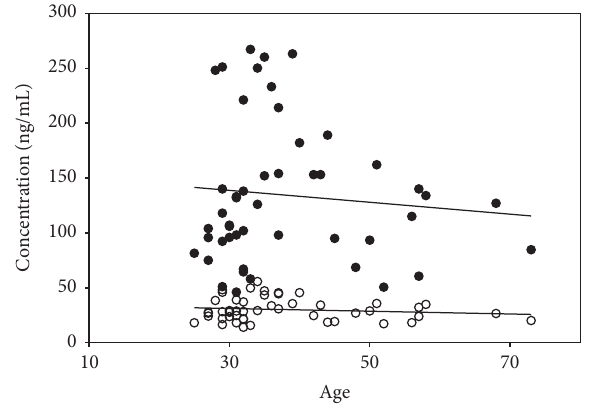
Figure 2: The levels of serum cortisol ( e ) and cortisone ( I ) with age in subjects.